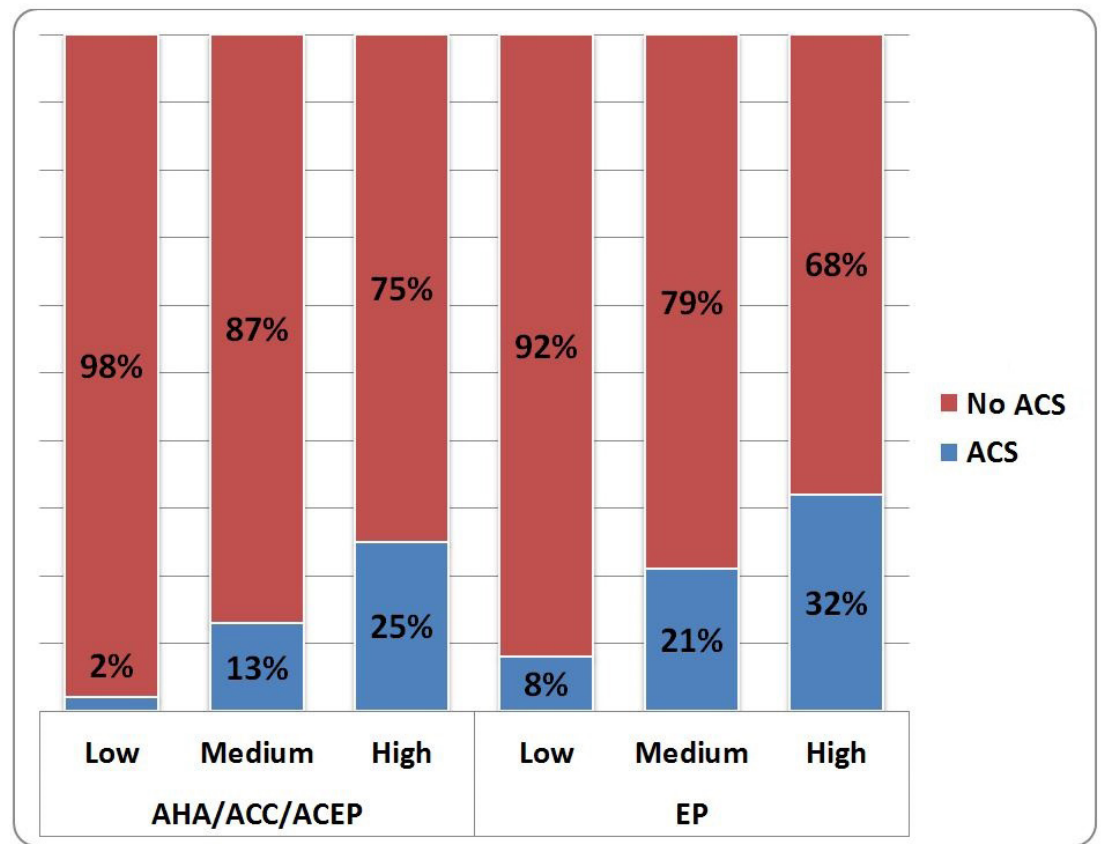
Figure 1. Patient’s risk assessment value versus final ACS